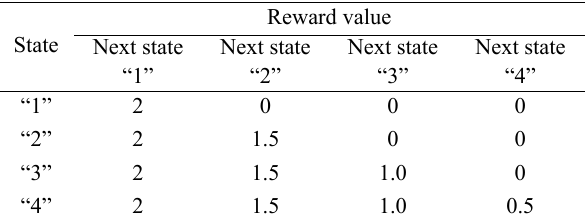
Algorithm 1 Framework of ERLDE Table 2 Reward values of different actions in different